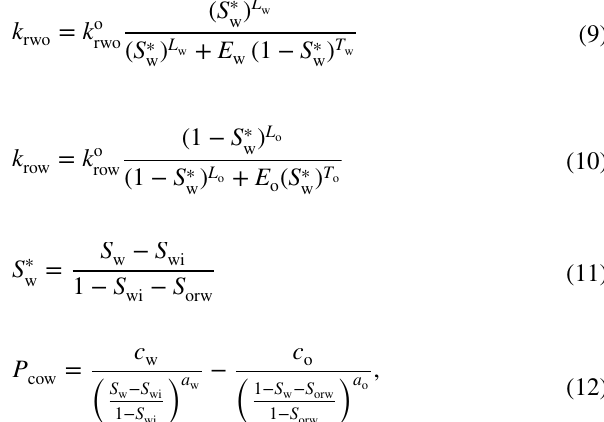
k r of HM and r of JBN